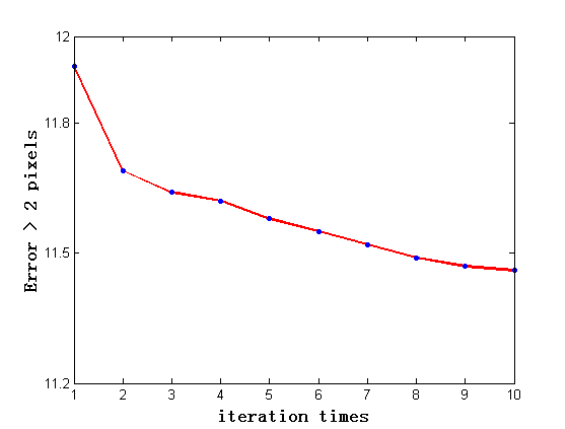
Figure 5. Bad 2.0 of different iteration times.